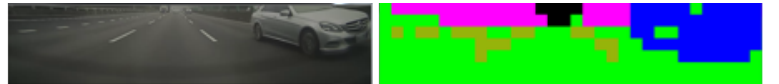
Figure 7. The system flowchart of the proposed overtaking detection technique. It consists of three basic modules: (1) pre-processing and segmentation, (2) convolutional neural network and repetitive pattern removal, and (3) tracking and behavior detection.